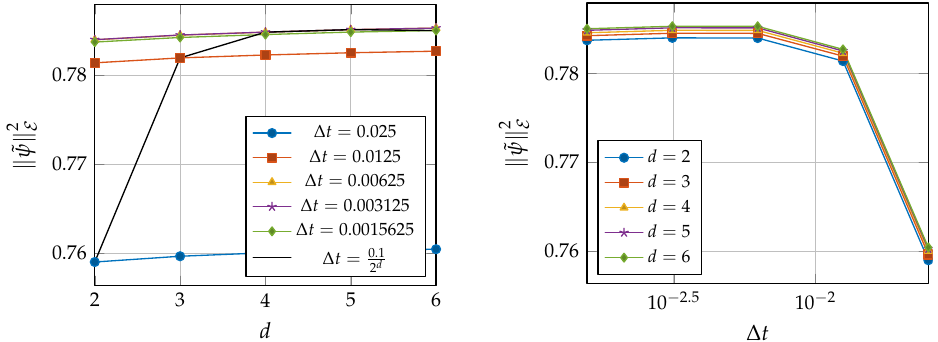
Figure 21. Squared space-time energy norm (60) of the approximated density on the parabola arc versus increasing B-spline degree (left) and refined time discretization (right).